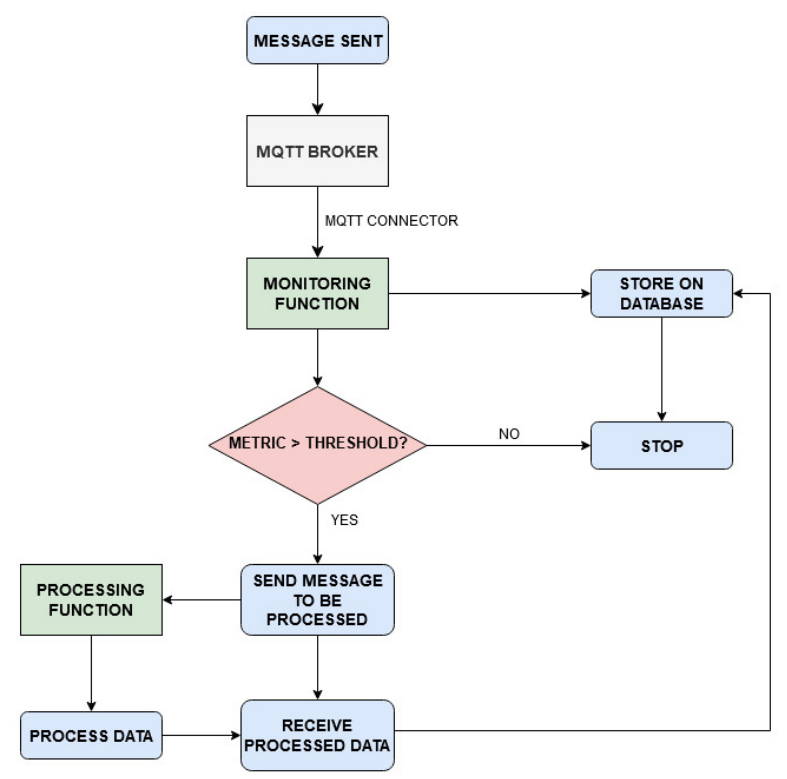
Figure 2. Flowchart for data monitoring and processing procedures.